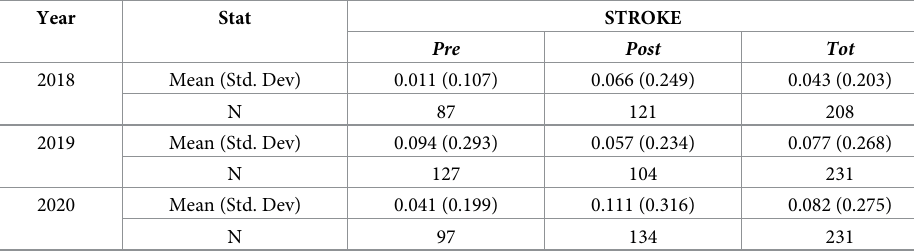
Table 2. Mortality rates of stroke (January 1- May 31, by year).